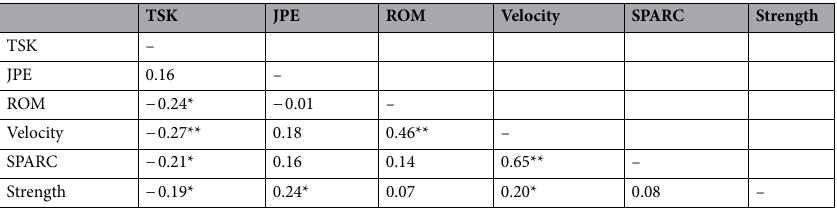
Table 4. Matrix of Pearson correlations between the investigated features. JPE Joint position error, ROM Range of motion, SPARC Spectral arc length, TSK Tampa scale for kinesiophobia. * p ≤ .05; ** p < .01.